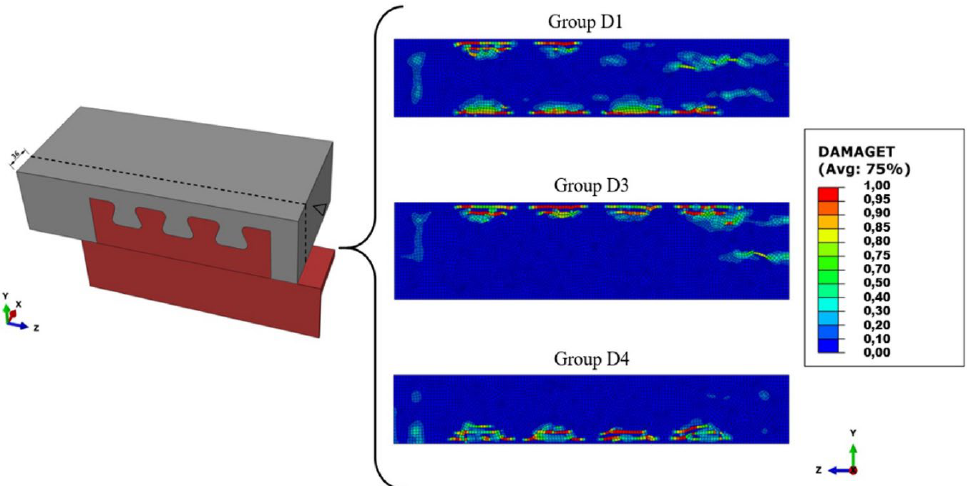
Figure 17. Tensile damage in the concrete